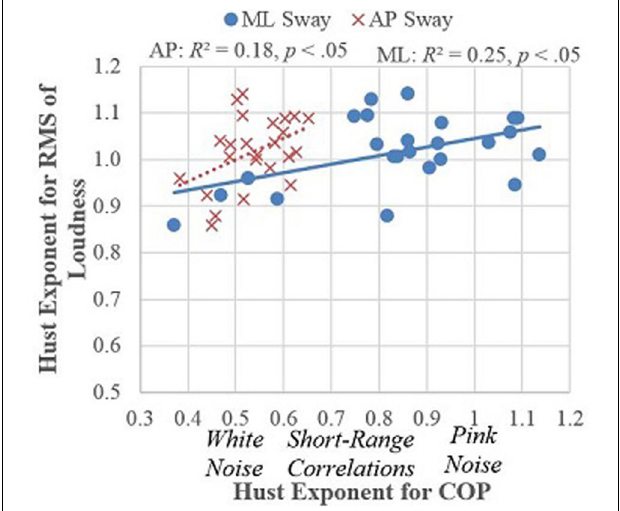
FIGURE 1 | Hurst exponents for ML and AP sway in 24 performances plotted against RMS of loudness.